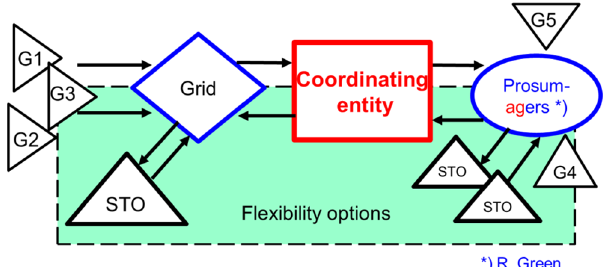
Fig. 11. The principle of “ New thinking ” in restructuring the electricity systems: from one-way delivery chains to multi- way fl ow – oriented systems with broad varieties of fl